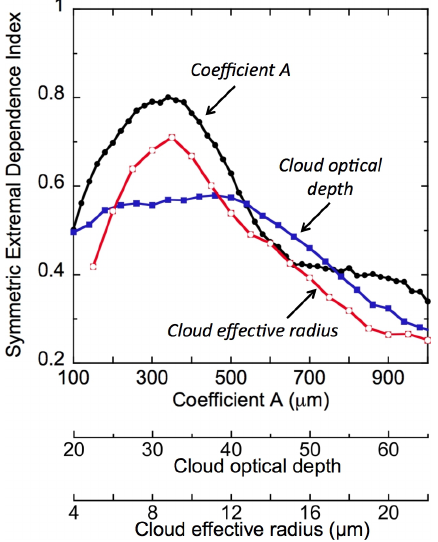
Figure 11. Heidke skill scores for three drizzle delineation methods. The first (red) uses cloud effective radius as delineation threshold, while the second (blue) uses cloud optical depth instead. The third (black) uses a dynamic threshold as a function of both cloud optical depth and effective radius with a coefficient A (see Eq. (7) in text for details).